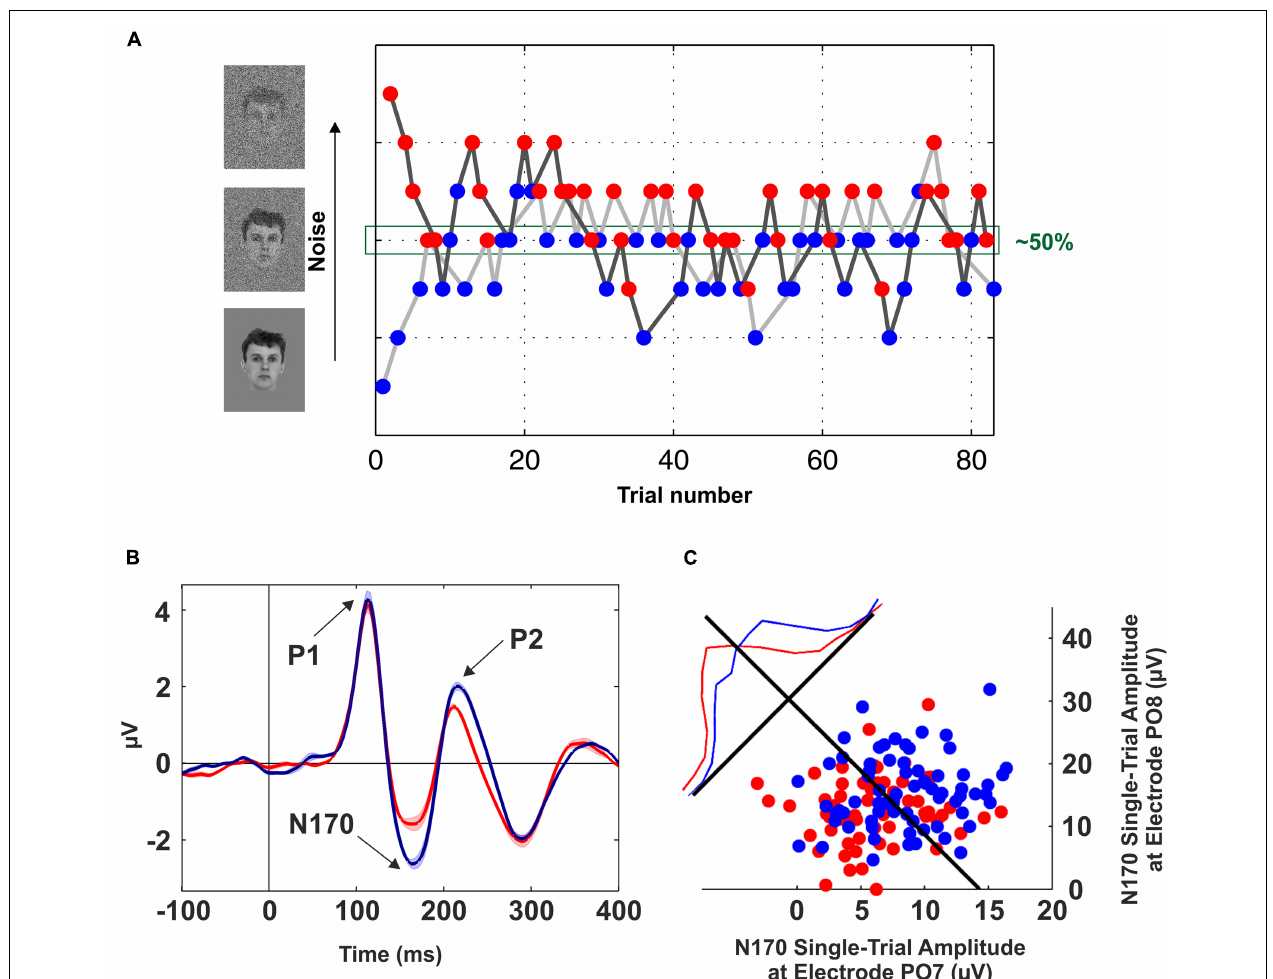
FIGURE 1 | Neural correlates of conscious face perception. (A) Brief flashes of faces with different levels of Gaussian noise were presented for 57 ms and combined with backward masking (mask duration: 443 ms). The noise level was tuned on a trial-by-trial basis following a double-staircase procedure, i.e., the noise was increased after a “seen” trial (blue dots) and decreased following an “unseen” trial (red dots). Trials from the upper staircase (dark gray line) and lower staircase (light gray line) were randomly interleaved. This method converges to a noise level of ∼ 50%. Data from one participant of the experiment described in Navajas etal. (2013). (B) Grand-average of scalp event-related potentials (ERPs) elicited by “seen” (blue line) and “unseen” (red line) faces